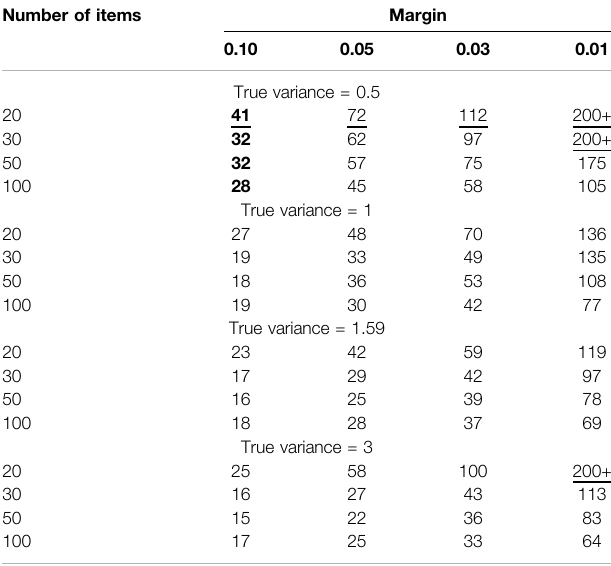
TABLE 3 | Mean number of comparisons per item required for accurate coverage of 95% CI around parameter estimates. Number of items True variance